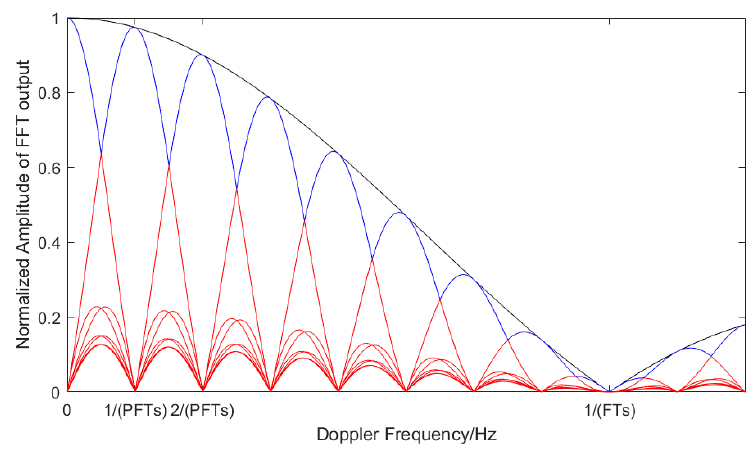
Figure 4. FFT output amplitude-frequency response.